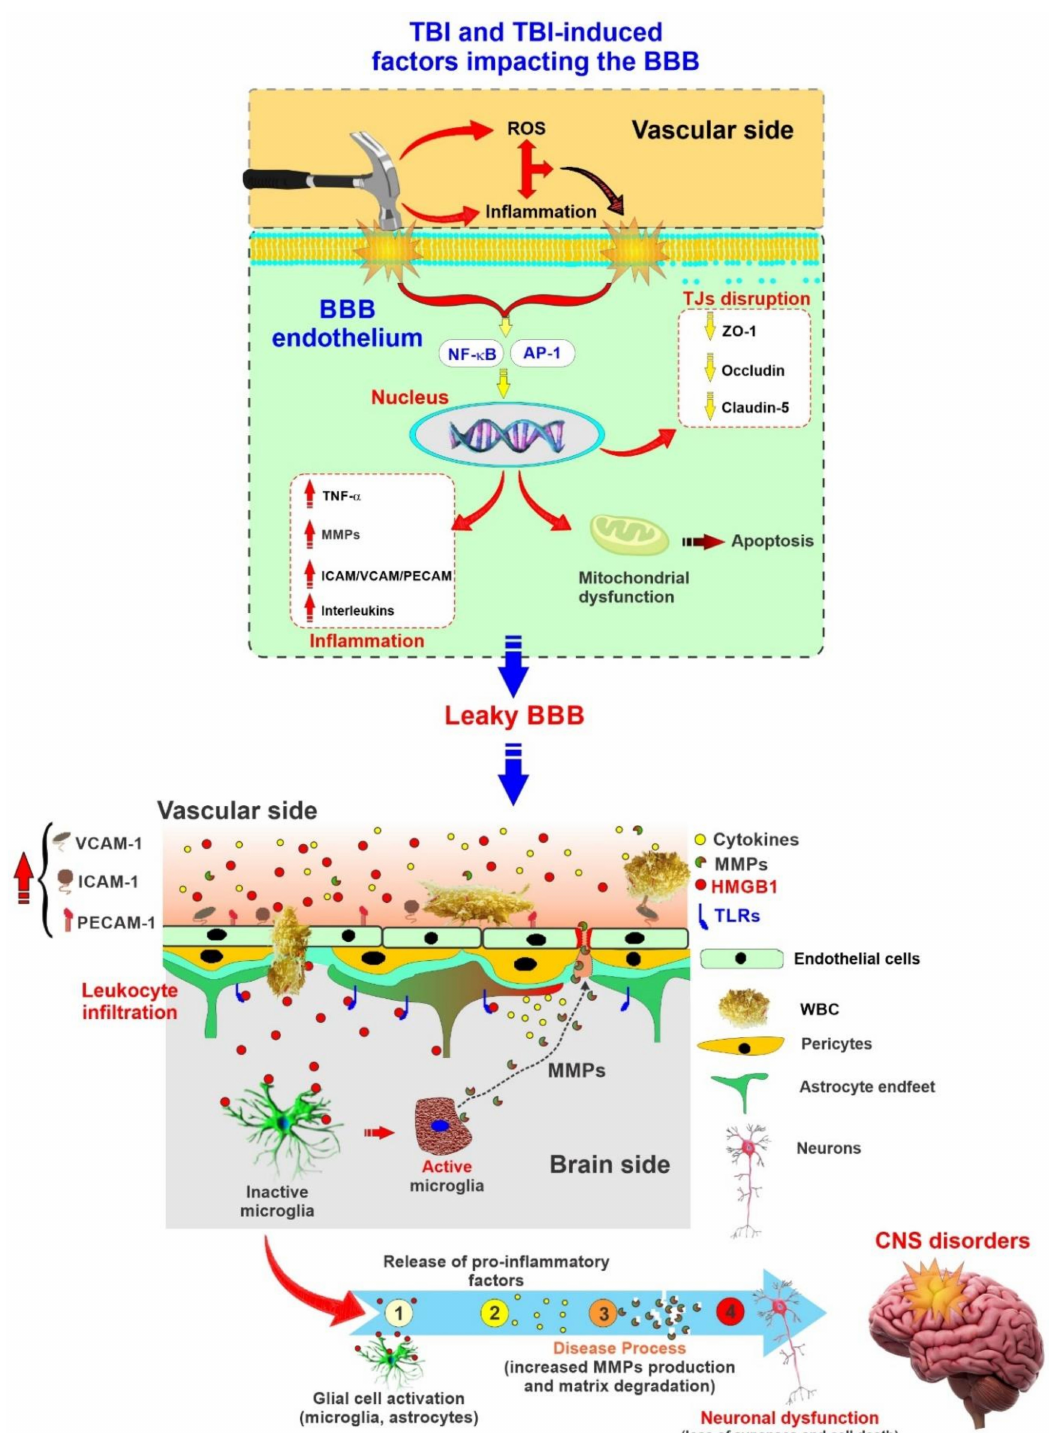
Figure 2. Schematic illustration depicting TBI and TBI-depending factors impacting the BBB and the onset of secondary brain injuries. Representation of BBB as a source and target of neuroinflammation in TBI. Note that inflammation and reactive oxygen species (ROS) generation associated with TBI can further impact the BBB in addition to mechanical trauma. The loss of BBB integrity further promotes neuronal damage and the onset of central nervous system (CNS)